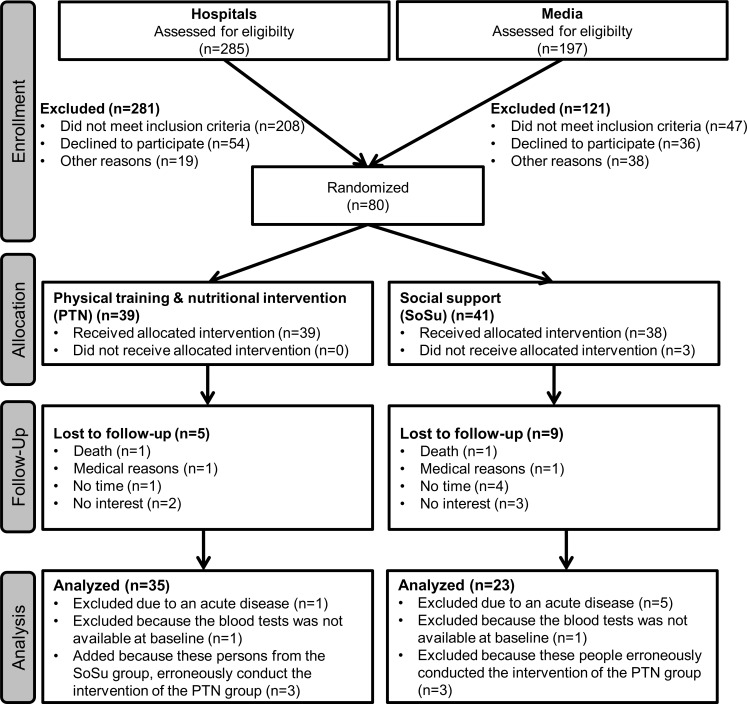
Participant flow.